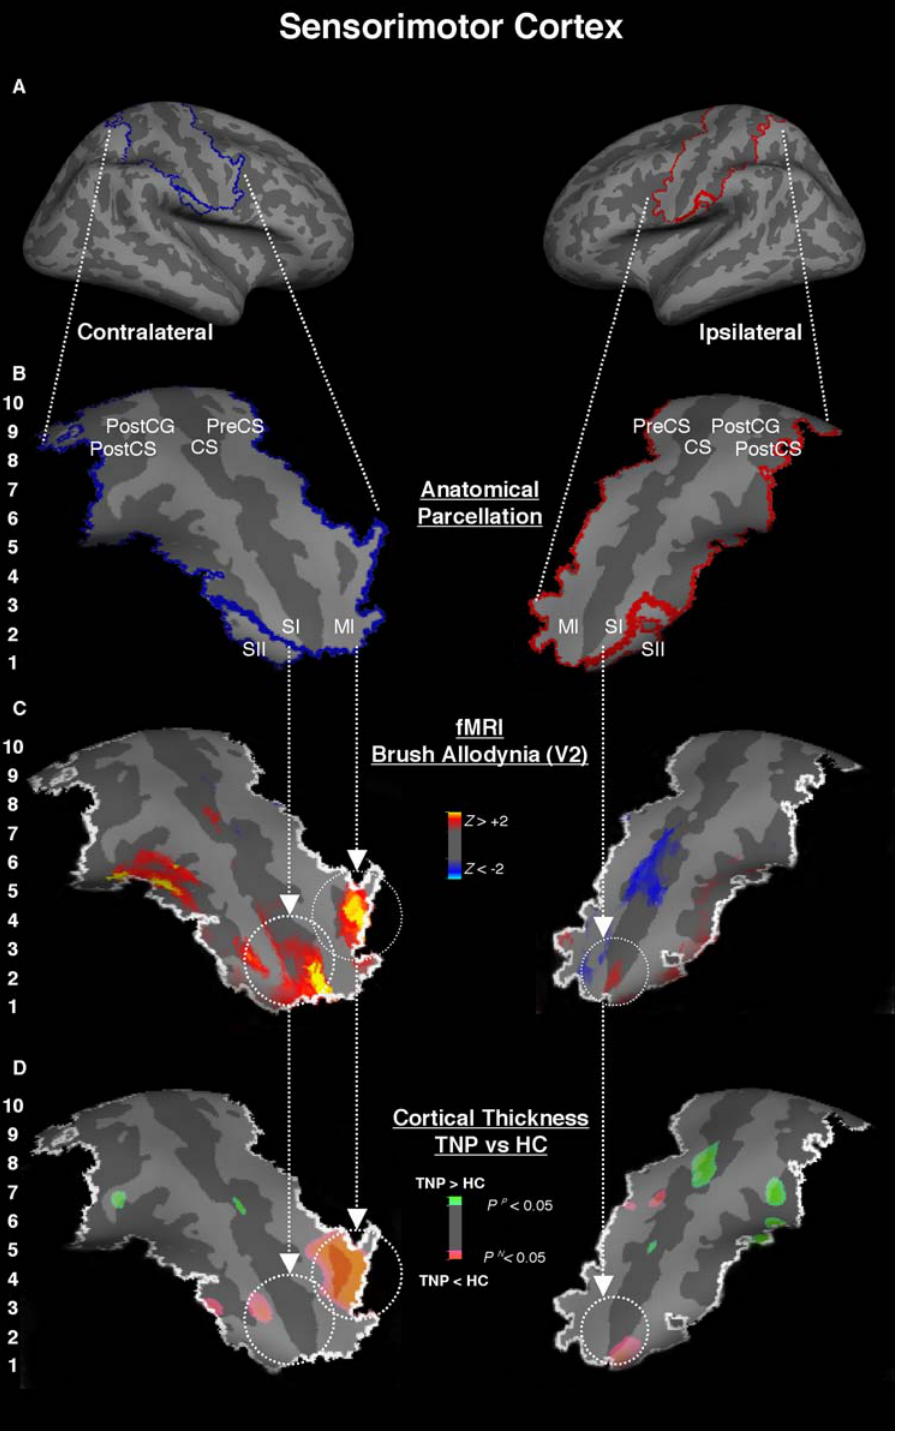
Figure 2. Somatosensory (SI & SII) and Motor (MI) Cortices. Panels A and B - SI and MI in this study were defined as the central sulcus including its posterior wall, and the precentral gyrus, respectively. SII was defined was the subcentral section lateroventral to the postcentral gyrus. In the hemispheres contralateral and ipsilateral to the TNP, regions of the sensorimotor cortex were segmented in ten equal vertical sections labeled from bottom to top in an ascendant manner, being section 1 located in the lowest portion, and section ten in the highest.; Panel C - Average BOLD deactivations (dark-light blue) and activations (red-yellow) in the sensorimotor cortex during allodynic brush of the affected V2 of the six TNP patients. The functional clusters were located in the most caudal region of SI and MI where the face and the neighboring regions are somatotopically represented; Panel D – Differences in cortical thickness between TNP and HC along sections of the sensorimotor cortex (pink=TNP , HC; green=TNP . HC). There is bilateral thinning in the most caudal region of the somatosensory cortex, where the face is represented, which was colocalized with functional clusters during allodynic pain. doi:10.1371/journal.pone.0003396.g002 PLoS ONE |